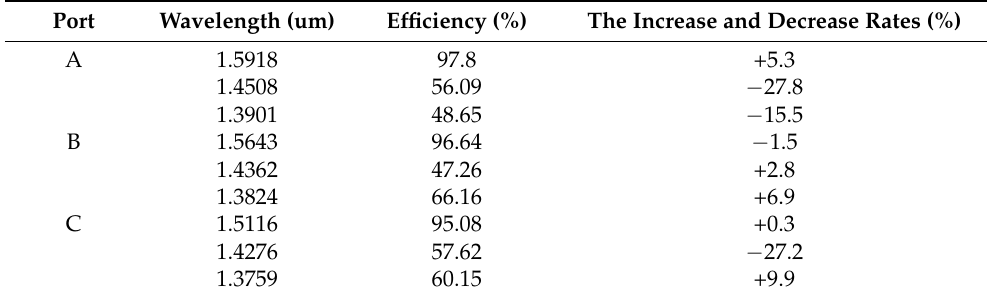
Table 4. Download efficiency of each channel of the filter to different wavelengths and the increase and decrease rates compared with those before